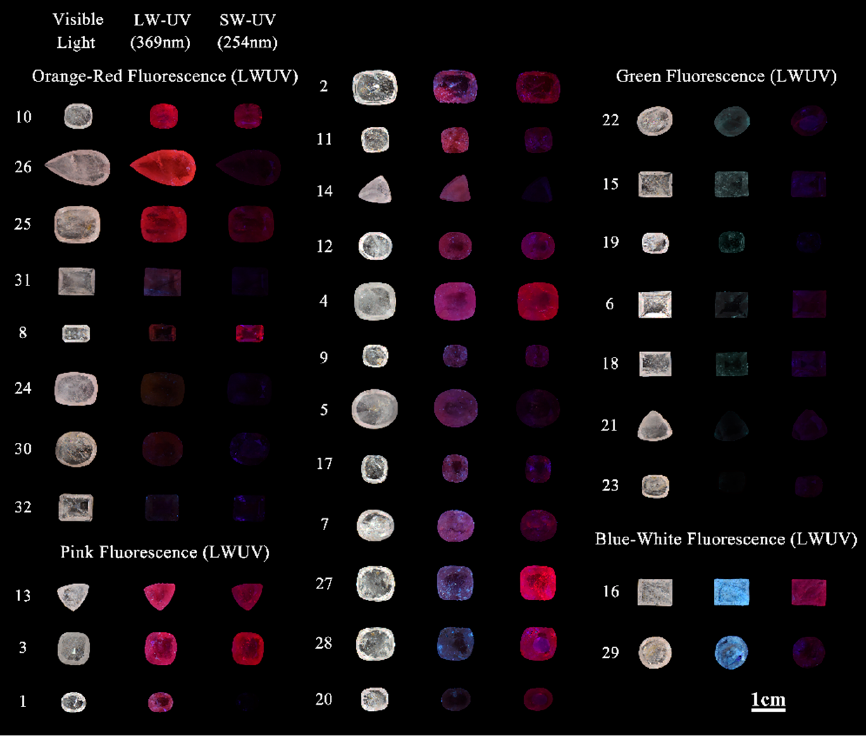
Figure 3. Thirty-two taaffeite samples show different fluorescence under LWUV and SWUV.